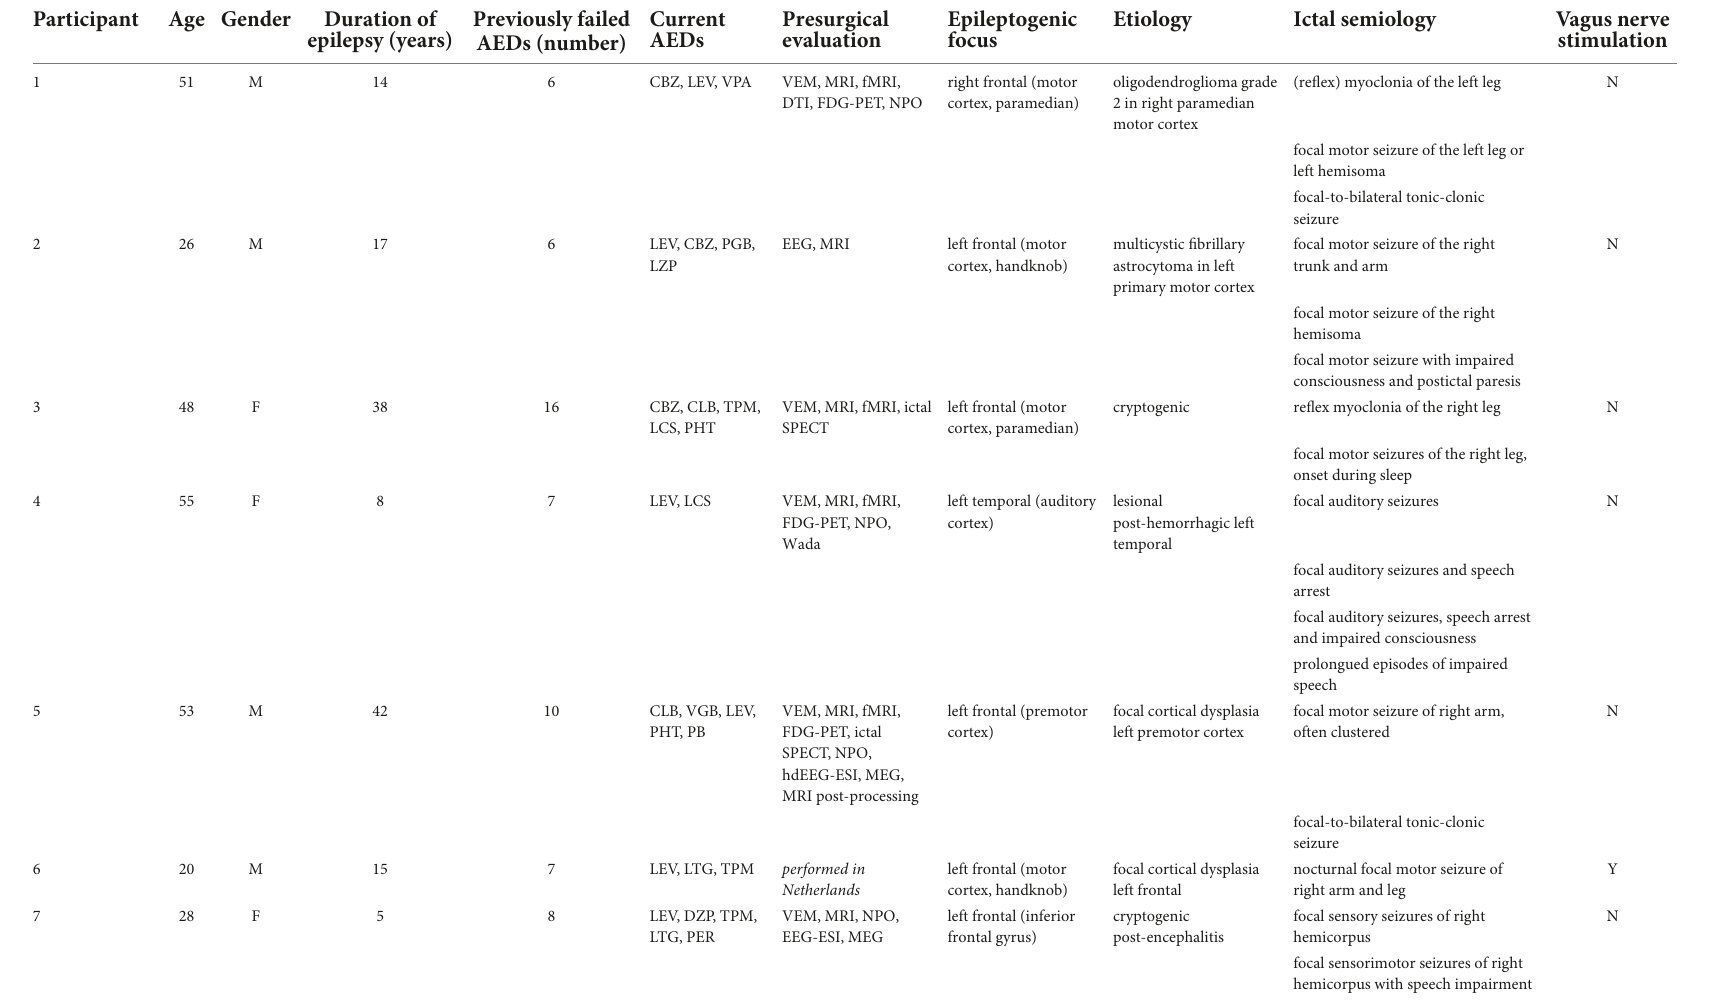
TABLE 1 Demographic and clinical data of the study